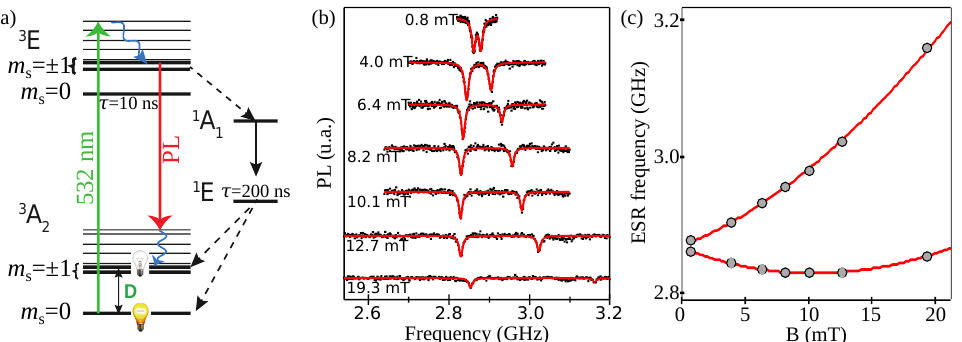
Figure 3. NV − center level structure. ( a ) Simplified electronic structure of the NV − center. ( b ) Example of optically detected magnetic resonance on a single NV − center in a bulk diamond. The magnetic field is applied with an angle θ = 74 ◦ with respect to the NV axis. ( c ) ESR frequencies from ( b ) (gray dots) compared with the full theory (red lines) obtained by computing the NV Hamiltonian eigenvalues (Equation (3)). Figure ( b , c ) are adapted from